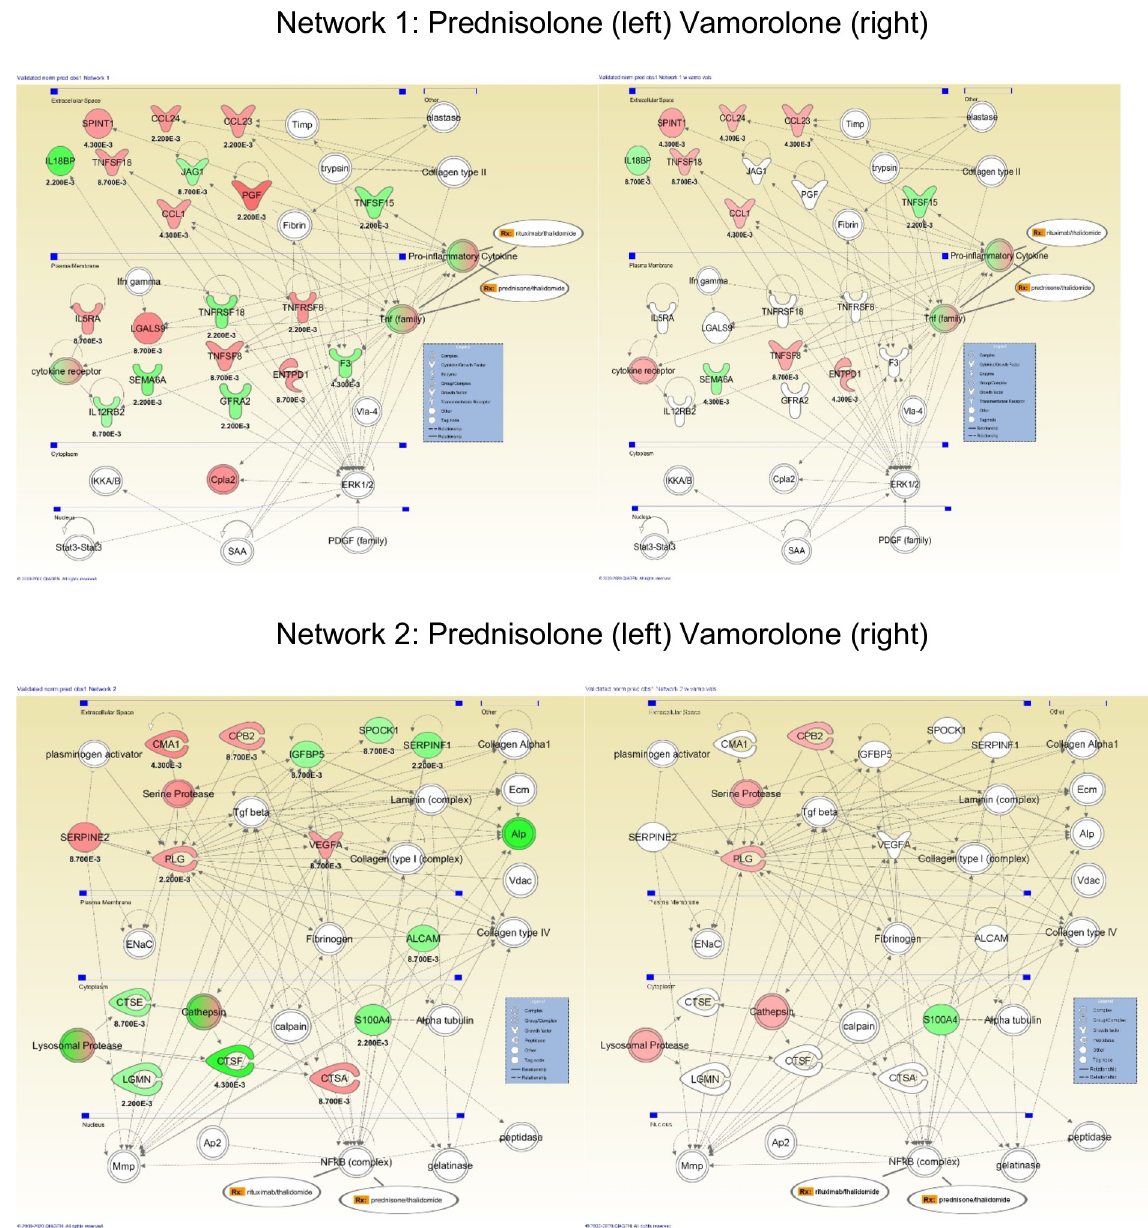
Fig 1. Ingenuity Pathway Analysis of prednisolone-responsive biomarkers identifies inflammatory cytokine and NF κ B pathways shared with vamorolone. The two most significant enrichment of protein-protein interactions for prednisolone-responsive biomarkers are shown (left panels), with vamorolone-responsive proteins overlaid onto the prednisolone networks. Red indicates upregulation, and green indicates downregulation, and color intensity correlates with the size of expression change. The multicolored elements are protein complexes where the underlying data and documentation are inconsistent with IPAs search algorithms, and therefore, the details are not